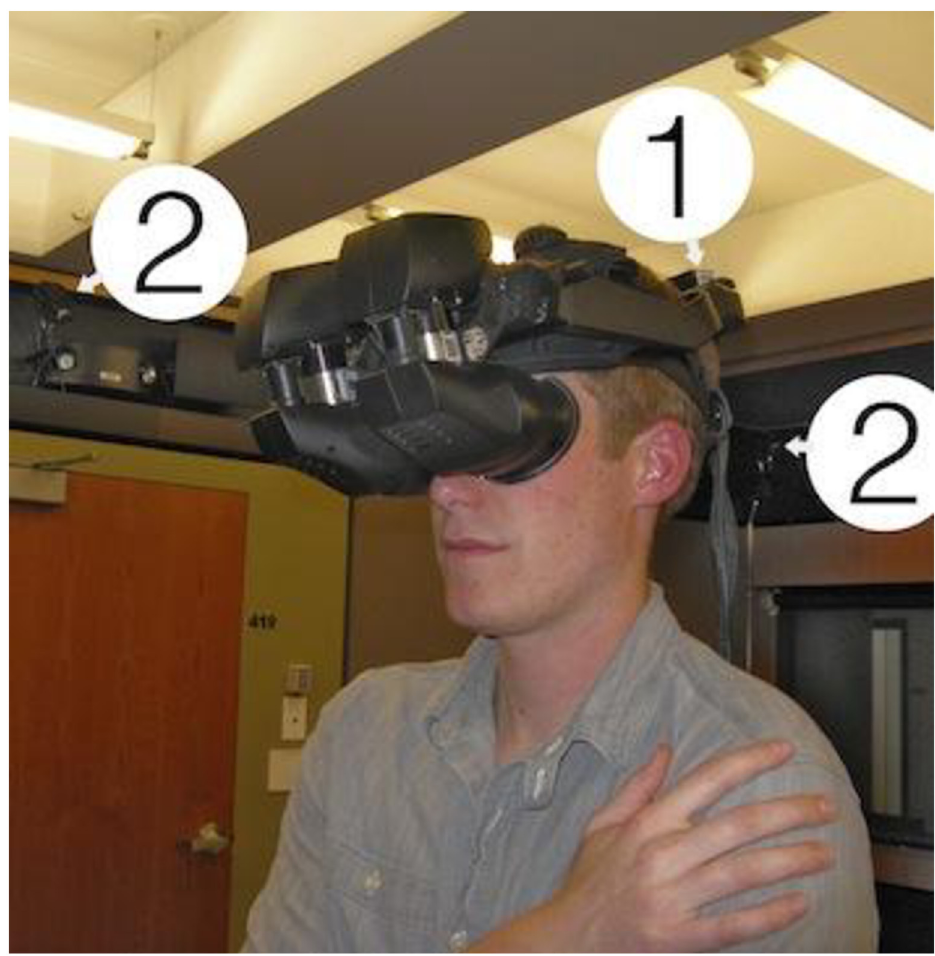
Fig 2. Subjects viewed the virtual environments using a head-mounted display (HMD). (1) An accelerometer allowed for naturalistic head movements during virtual exposure and (2) an optical infrared camera system recorded subjects ’ gross body position in virtual space, allowing subjects to navigate the virtual environments via natural walking patterns.